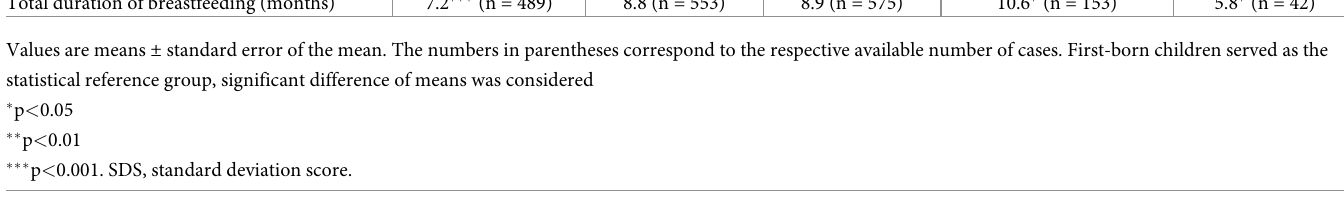
these AKGs over a longer period of time, which reduces overweight [38] and could lead to a lower risk of having overweight as an adult [39]. Thus, the approach of BMI-SDS of third-or- later-born children was likely achieved because they had the longest breastfeeding period, of almost eleven months, and the highest physical activity. Studies have shown that children with siblings generally have higher activity levels [40], par- ticularly children with older siblings [41]. Siblings can be playmates and encourage active par- ticipation in sports. Siblings also act as additional caregivers, which sometimes makes active play possible in the first place. It is therefore not surprising that having fewer siblings is associ- ated with reduced physical activity [6]. The results of our study confirm these findings, as only children had the lowest activity. A general decrease in activity levels among children from age 7 onwards [42] may have additionally contributed to the steady increase in BMI among only children. Twins, along with third-born children, tended to participate in physical activity very Table 4. Duration of breastfeeding by sibling